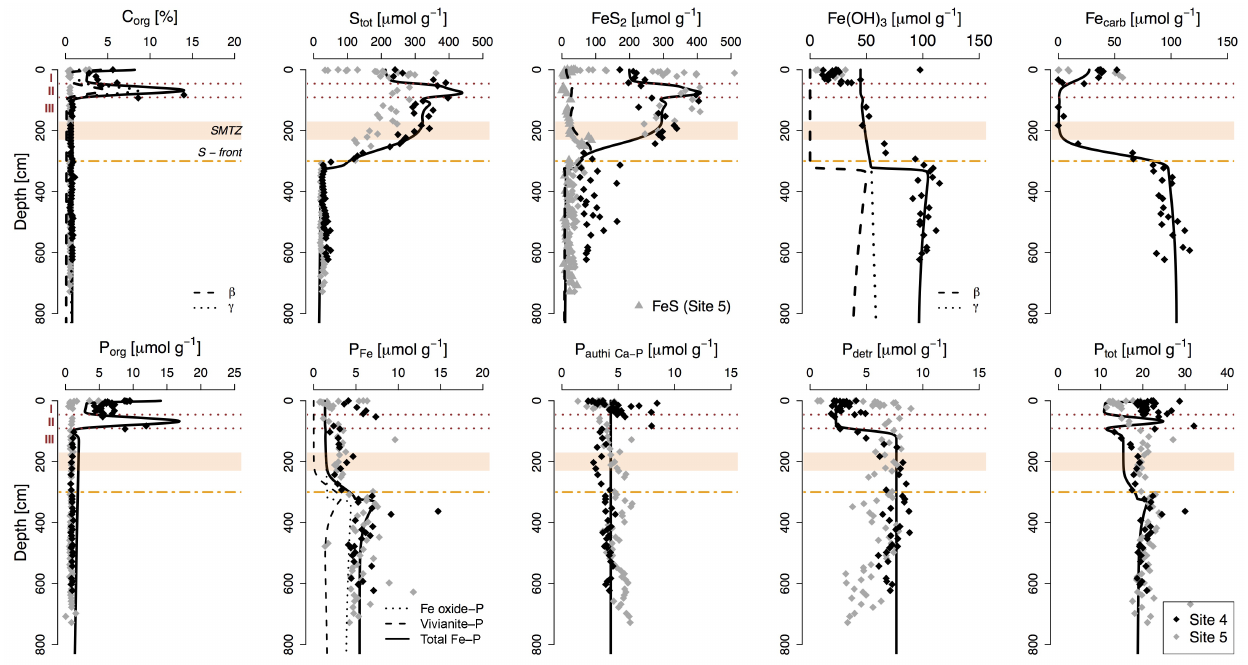
Figure 5. Solid-phase sediment profiles for site 4 (black diamonds) and 5 (gray diamonds). Fe oxides represent the sum of amorphous, crystalline and recalcitrant oxides, i.e., Fe ox1 , Fe ox2 and Fe mag (Table 1, Fig. S4). Fe carb was corrected for apparent AVS dissolution during the Na acetate extraction step (the uncorrected Fe carb data are given in Fig. S4). Black lines represent profiles derived from the diagenetic model. Red dotted lines and roman numbers indicate the transitions between the lithological Unit I (modern coccolith ooze), Unit II (marine sapropel) and Unit III (limnic deposits). The orange bar represents the sulfate-methane transition zone (SMTZ), and the orange dashed line shows the current position of the downward-migrating sulfidization front (S